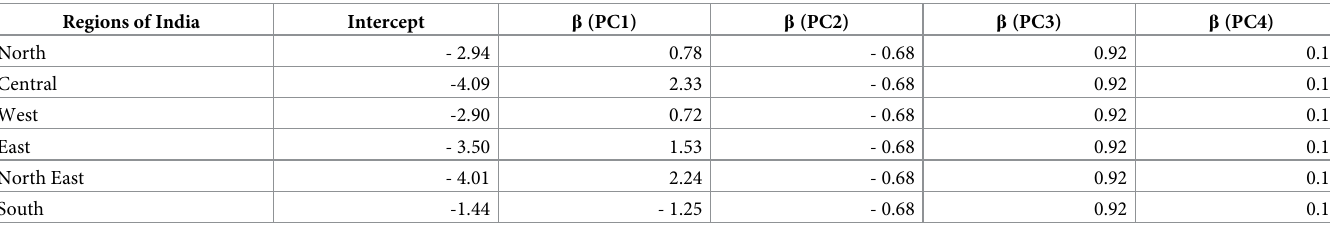
Table 4. Region specific intercept and regression